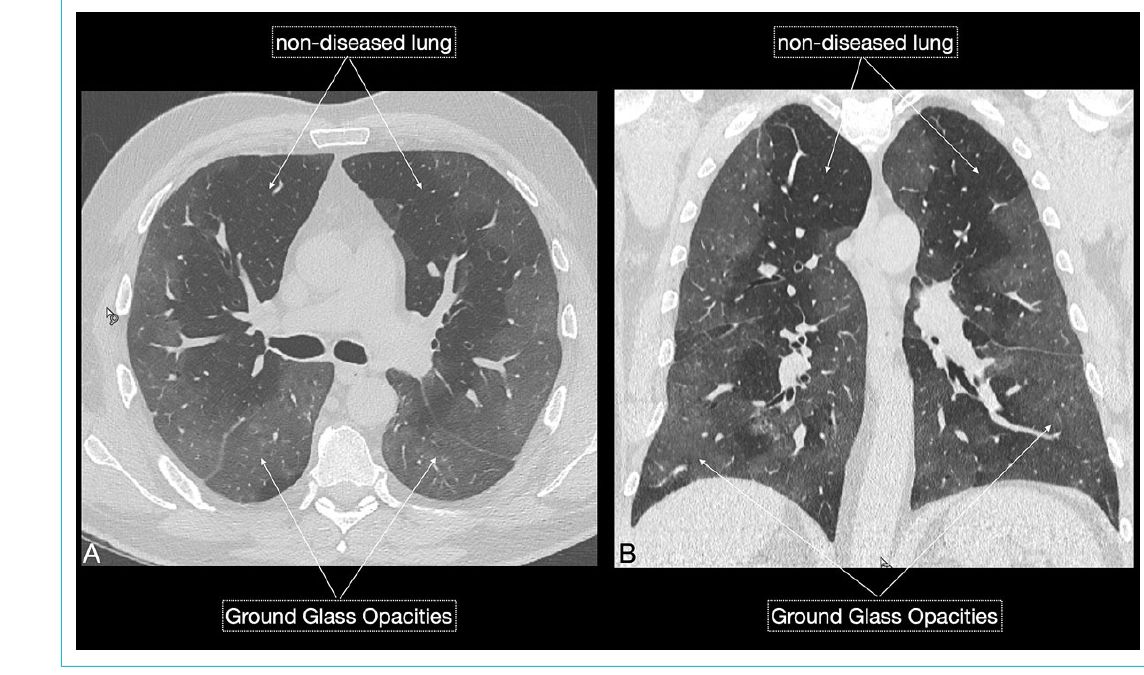
Figure 3 AB: A 57-year-old male patient with cough, fever, myalgia and arthralgia for approximately 10 days was admitted to the emergency department. Laboratory work revealed lymphopenia, elevated lactate dehydrogenase, C-reactive protein and D-dimers. SaO 2 was 82% on room air. RT-PCT test was positive for COVID-19. Chest computed tomography (CT) (A, B) revealed extensive ground glass opacities (Total Severity Score of 13/20 suggests a severe and critical course). Fairly immediate respiratory exhaustion led to